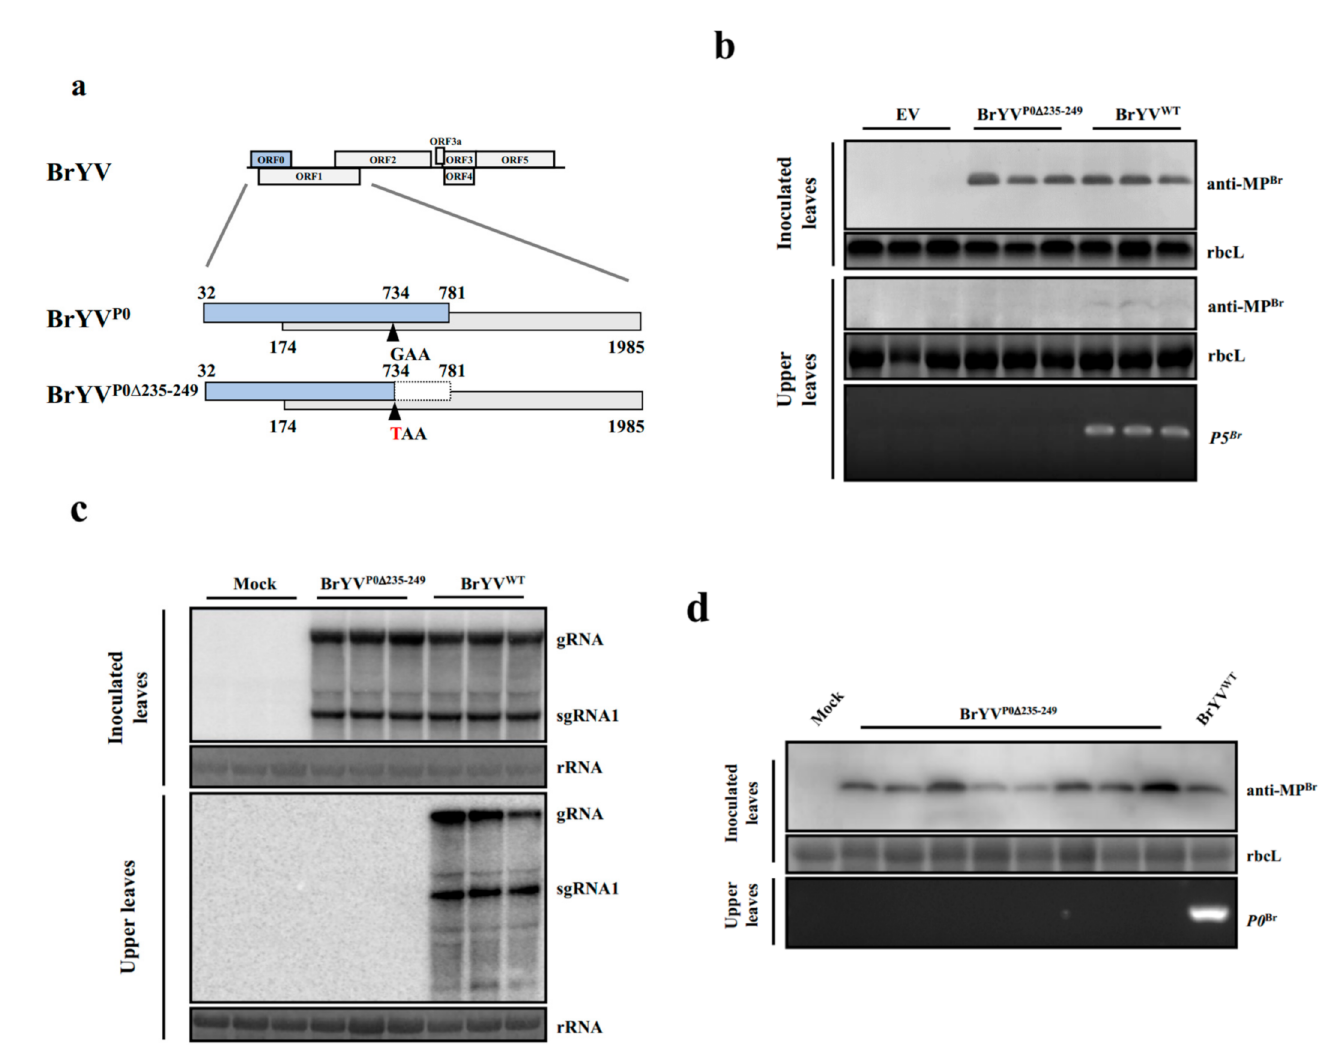
Figure 3. BrYV P0 ∆ 235–249 mutant virus showing the capability to produce a systemic infection. ( a ) BrYV P0 ∆ 235–249 mutation is incorporated into the P0 coding sequence without disrupting the P1 sequence. ( b ) Protein determination in virus-inoculated leaves at 2 dpi and the upper leaves of N. benthamiana plants at 14 dpi by Western blotting analysis with a BrYV-MP-specific antibody (anti-MP Br ). Stained rubisco is shown to indicate equal lane loading. RNA determination from the upper leaves of N. benthamiana at 14 dpi as assessed by RT-PCR using P5 Br gene-specific primers. ( c ) Northern blotting analysis of viral RNAs from inoculated leaves at 2 dpi and upper leaves of N. benthamiana plants at 14 dpi. ( d ) Protein determination in virus-inoculated Arabidopsis thaliana leaves at 5 dpi by Western blotting analysis with a BrYV-MP-specific antibody (anti-MP Br ). RNA determination in the upper leaves of Arabidopsis thaliana plants at 14 dpi as assessed by RT-PCR using P0 Br gene-specific